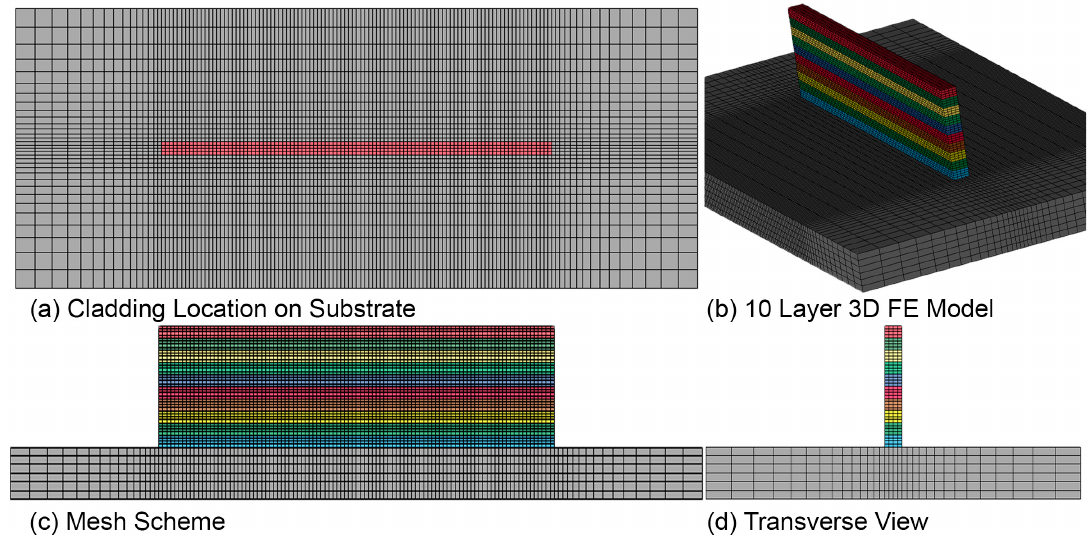
Figure 5. Three-dimensional FEM model with uniform mesh on layers and nonuniform mesh on the substrate.